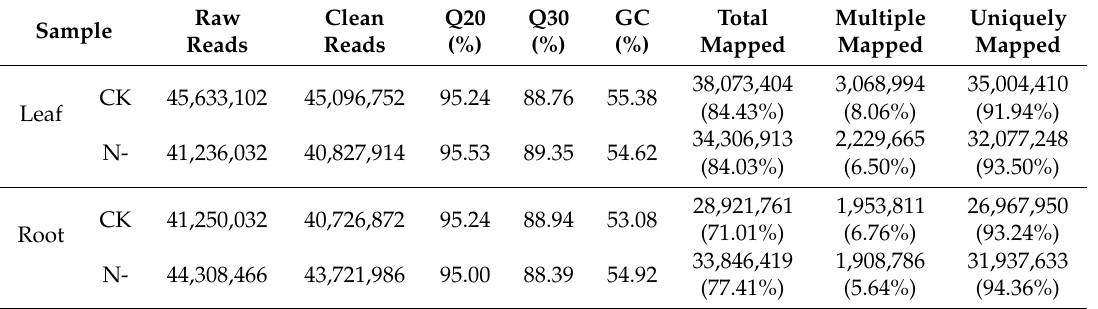
Table 2. Summary of RNA-seq data and reads mapping. Di ff erent treatment represents: The CK and N- of leaf, the CK and N- of